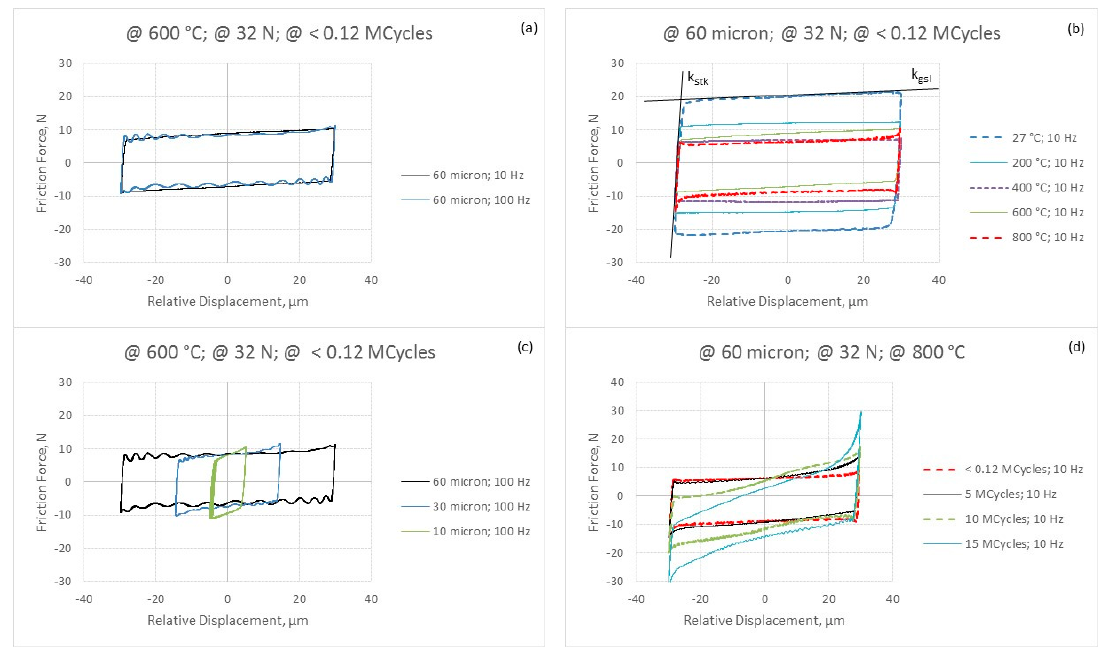
Figure 5. Hysteresis loop as a function of some process parameters: ( a ) frequency; ( b ) temperature; ( c ) stroke; ( d ) wear state.